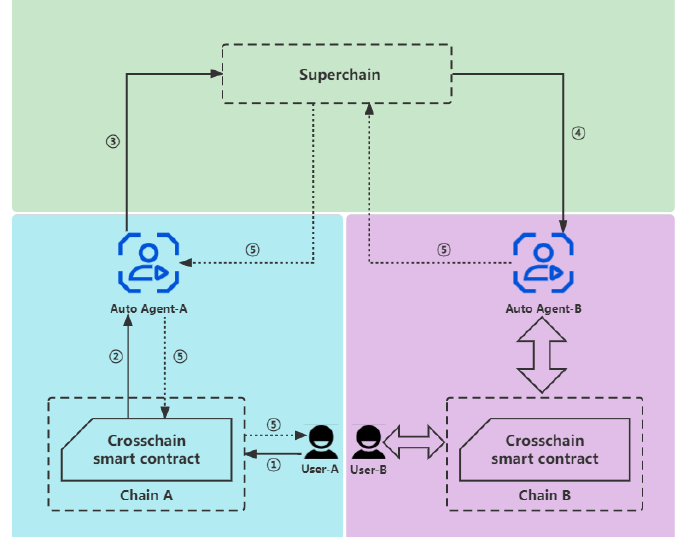
Figure 1. The framework of the basic cross-chain